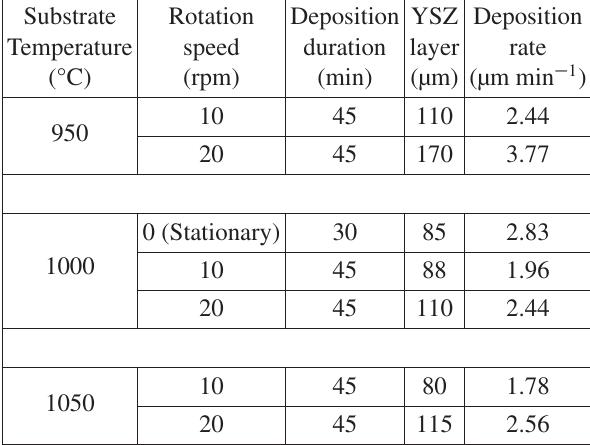
Table 2. Thickness and deposition rate of the YSZ coatings obtained under various processing conditions.